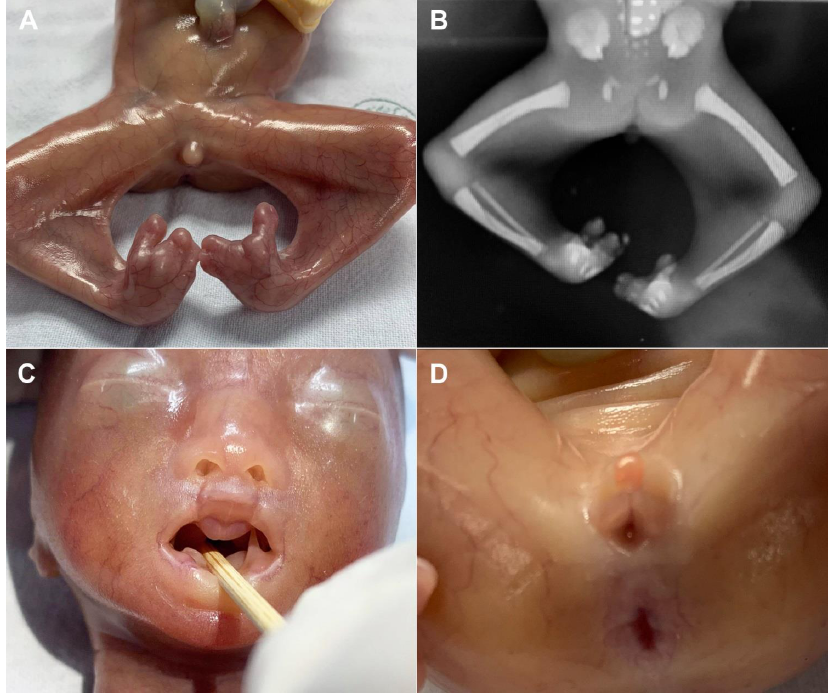
Figure 2. ( A ) Postnatal findings of the popliteal webbings and syndactyly/ectrodactyly; ( B ) X-ray of the lower limbs (abnormal postures); ( C ) Postnatal findings of the grooves in the upper lip and intraoral soft tissue adhesion; ( C ) Ambiguous genitalia (poorly developed scrotum with hypospadias).